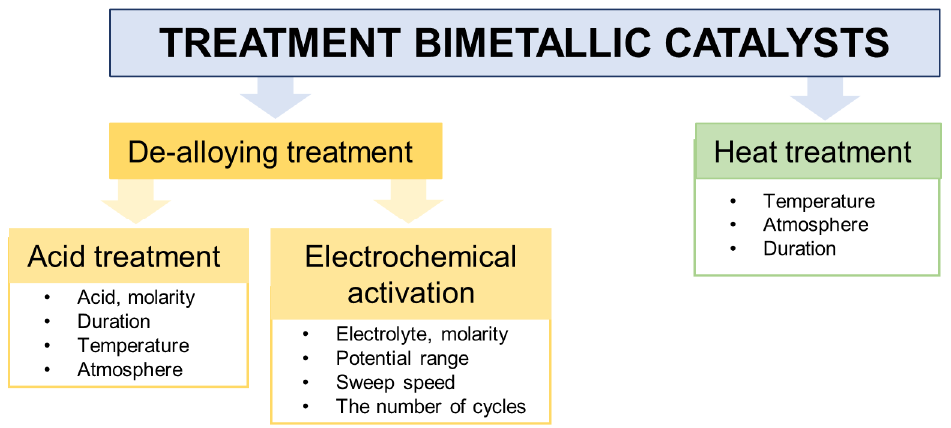
Figure 1. Schematic representation of treatment types of bimetallic catalysts. The parameters that can be varied during processing are indicated.